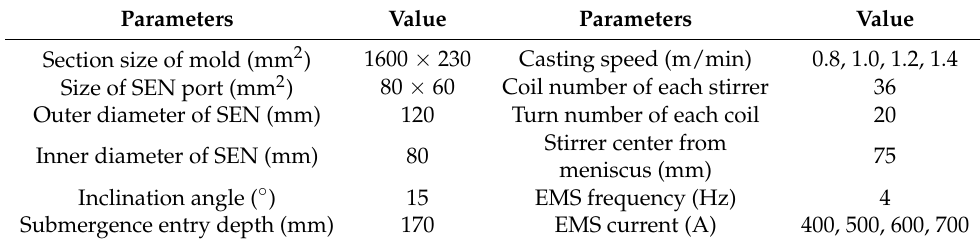
Figure 1. Schematics of the calculation model: ( a ) model used for electromagnetic simulation (surrounding air cuboid is not shown), ( b ) model used for fluid simulation. Table 1. Process parameters used in mathematical simulation.